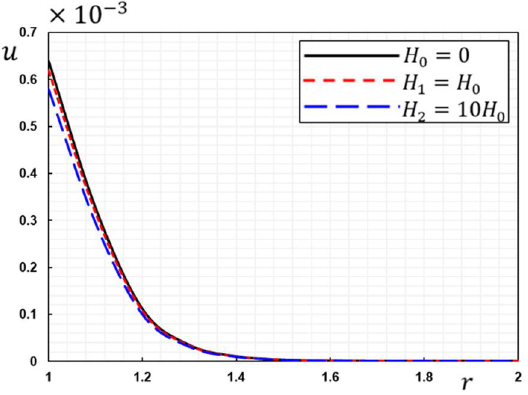
Figure 3. The displacement distribution, u , versus the axial magnetic field, H 0 .